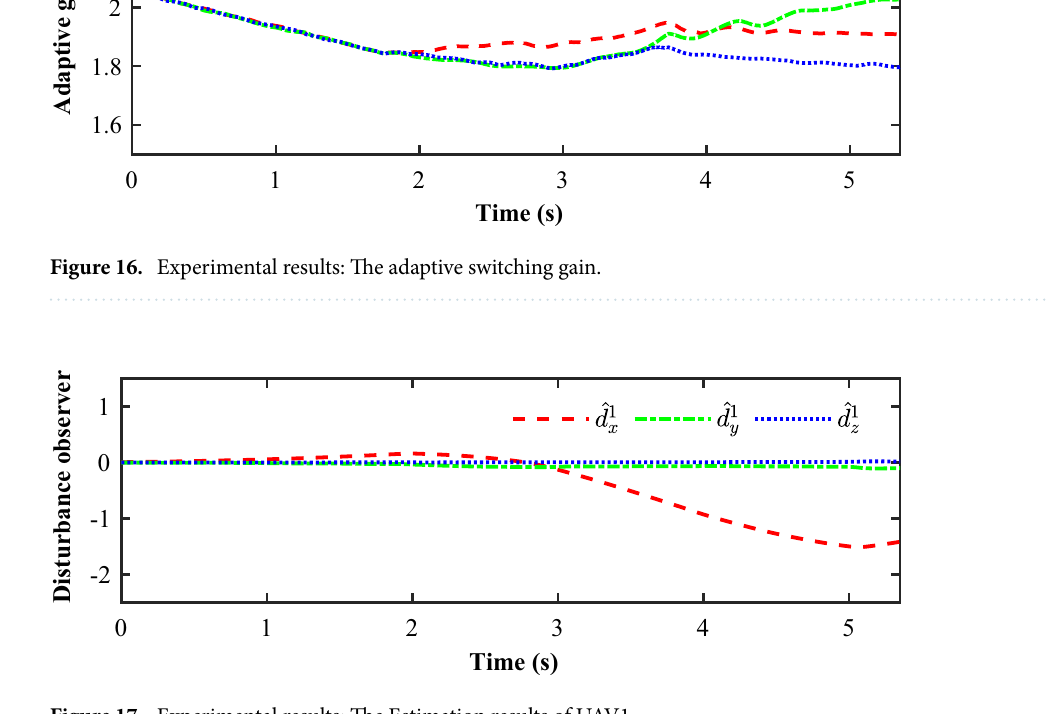
Figure 17. Experimental results: The Estimation results of